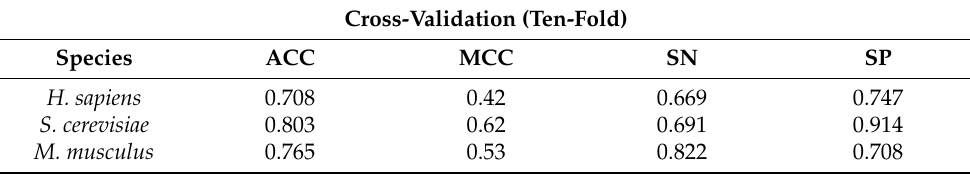
Table 1. The cross-validation scores of the ensemble predictor for three benchmark